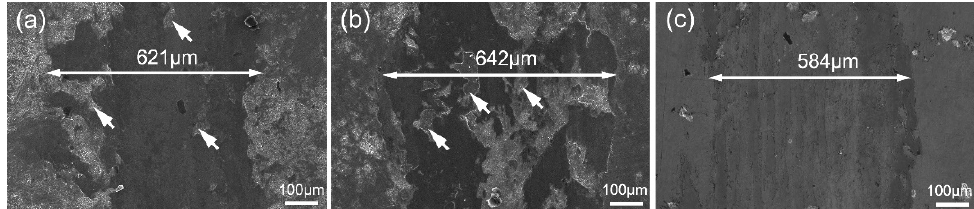
Figure 11. SEI images showing the wear morphologies of the three samples: ( a ) BCr-15 sample; ( b ) BCr-30 sample; ( c ) BCr-60 sample.